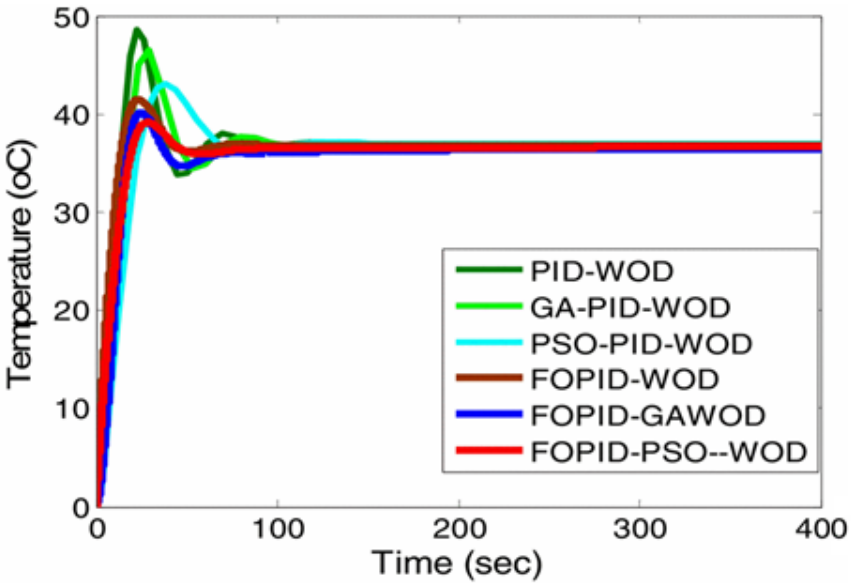
Figure 19. Final output plot of ambulance response in terms of time and temperature.